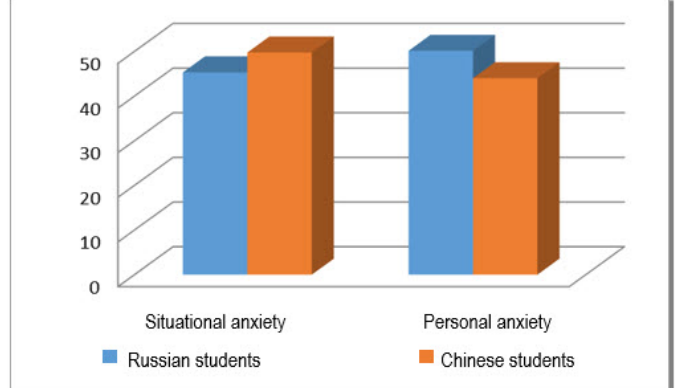
Figure 1. Comparative analysis of the features of anxiety state in Russian and Chinese students studying remotely (n=80)